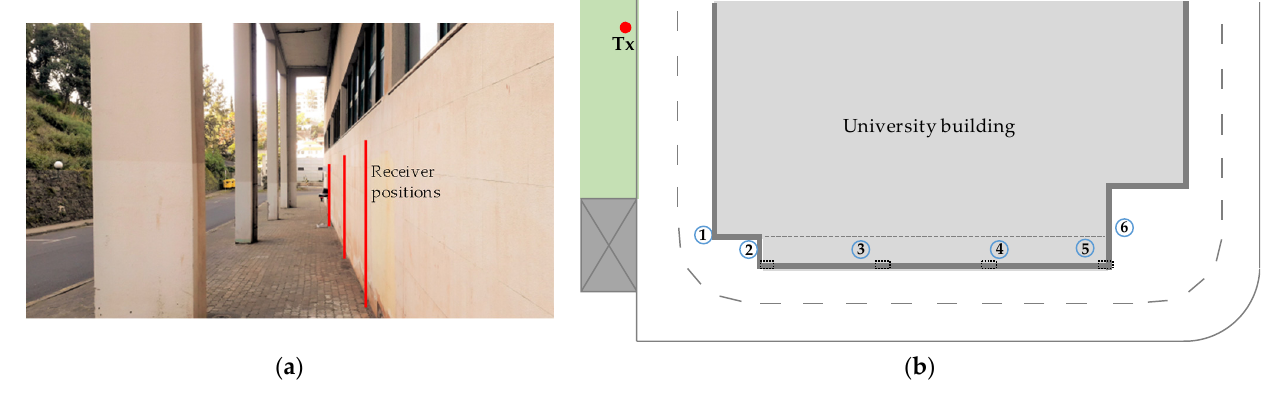
Figure 2. Location 2—street around the building: ( a ) image of the location; ( b ) plan with the transmitter and receiver positions.